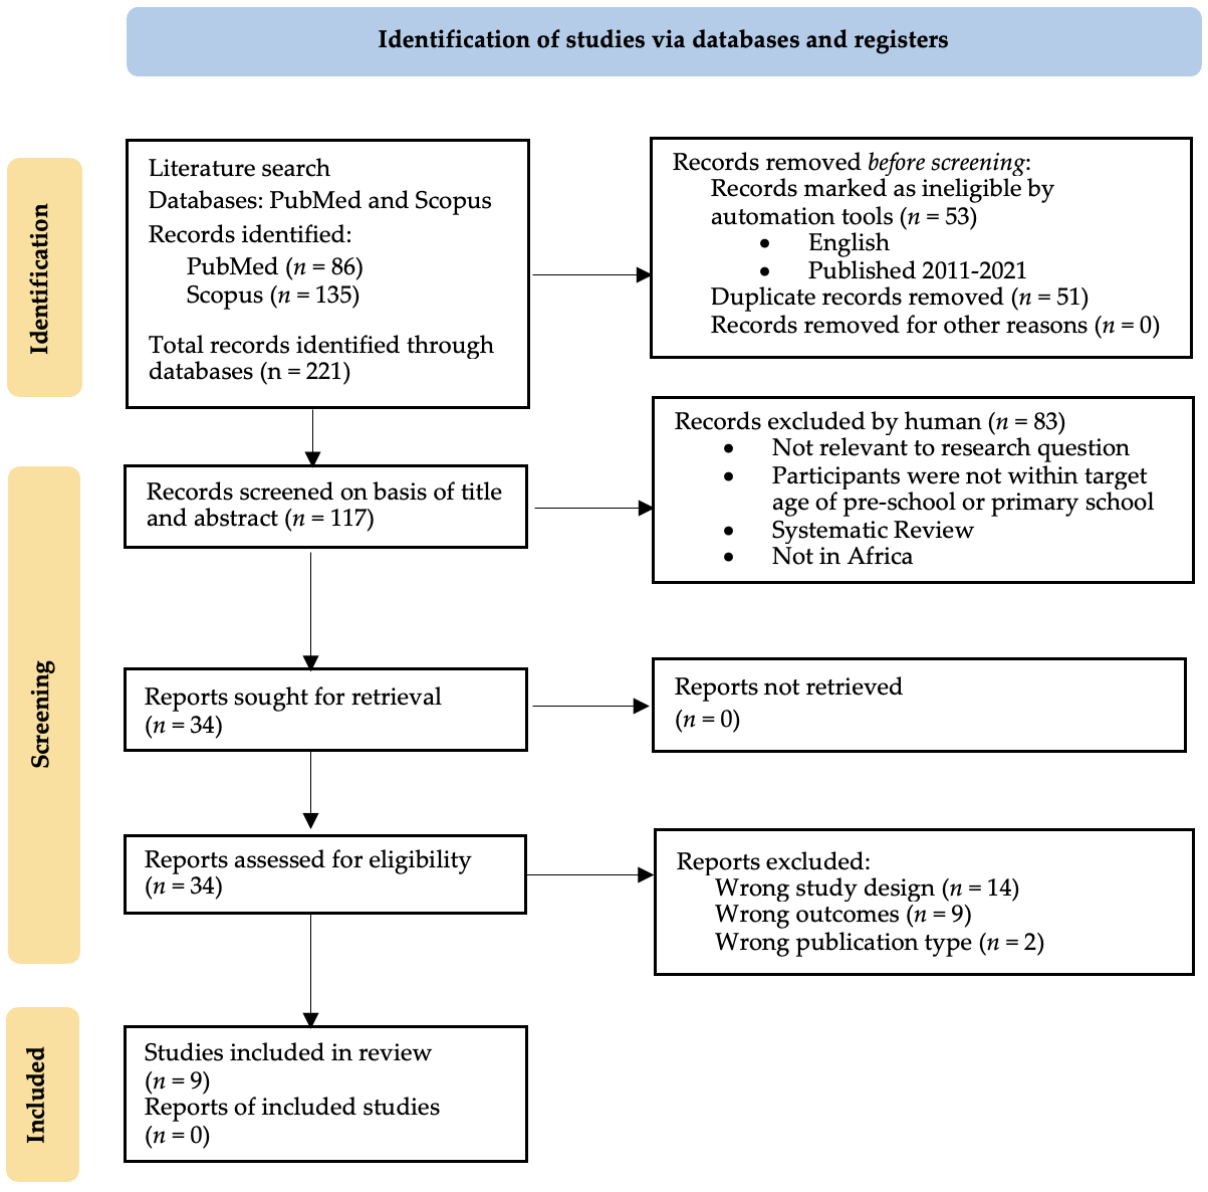
Figure 1. PRISMA screening process for selection of articles for review [17]